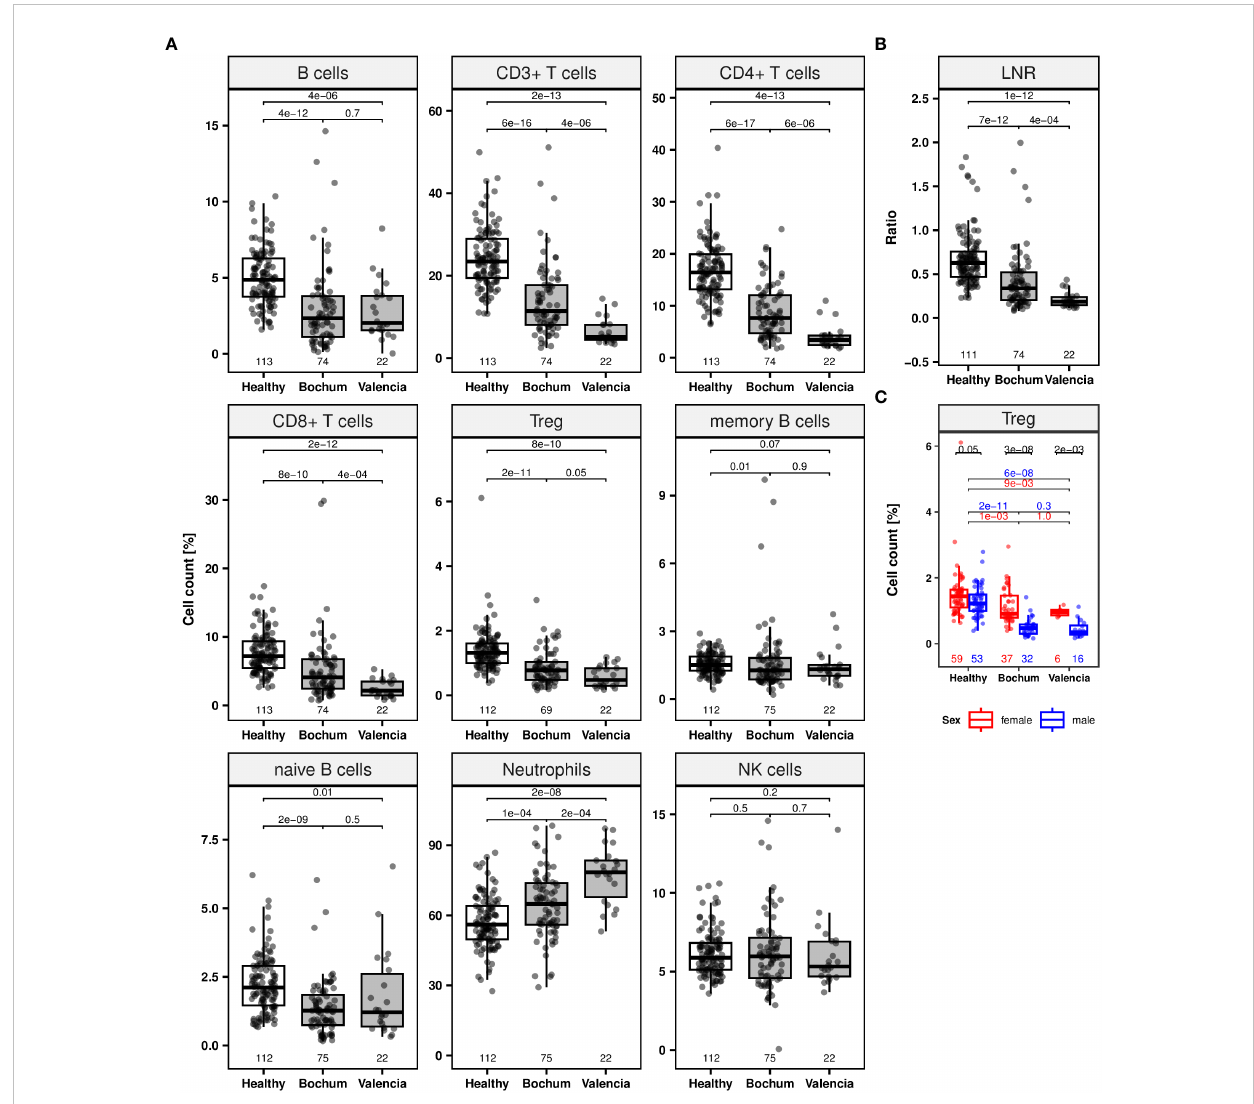
FIGURE 2 Lymphocyte populations of COVID-19 patients at initial hospital admission. Jittered scatters indicate actual cell count for a single sample at the fi rst visit is de fi ned as timepoint at initial admission. Boxes display the interquartile range and different coloured boxes indicate healthy (white box, n = 113) or COVID-19 patient cohorts from two clinical sites (grey boxes, Bochum, n = 75; Valencia, n = 22). Whiskers extend maximally 1.5 times the interquartile range from the upper/lower end of the box. Observations farther than that are considered outliers. All p values relate to the Wilcoxon rank sum test for median differences and are displayed above the respective boxplots. (A) Boxplots for lymphocyte subpopulations (CD19 + B, CD3 + , CD4 + , CD8 + , regulatory T (Treg), memory, naïve B cells, neutrophils and CD56dim natural killer [NK] cells). (B) Boxplot of lymphocyte-to-neutrophil ratio (LNR). (C) Boxplots for Treg counts separated by sex (colors: female = red, male =